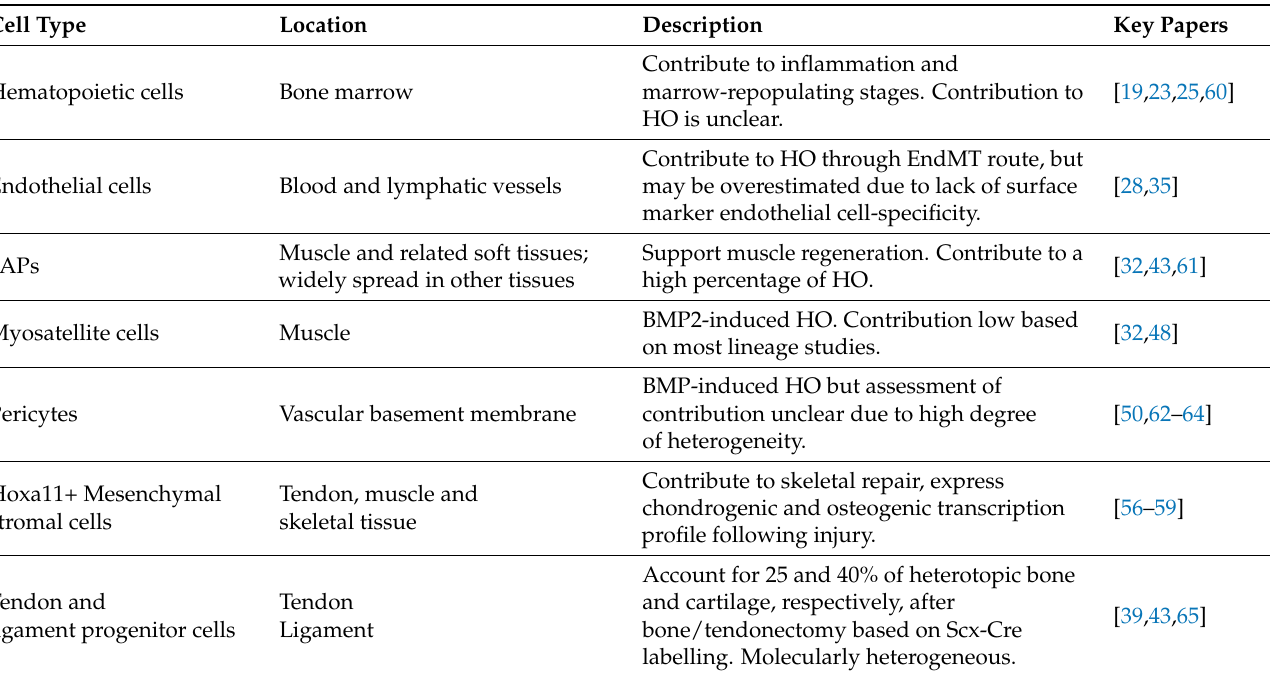
Table 1. Overview of cell types investigated for their contribution to heterotopic